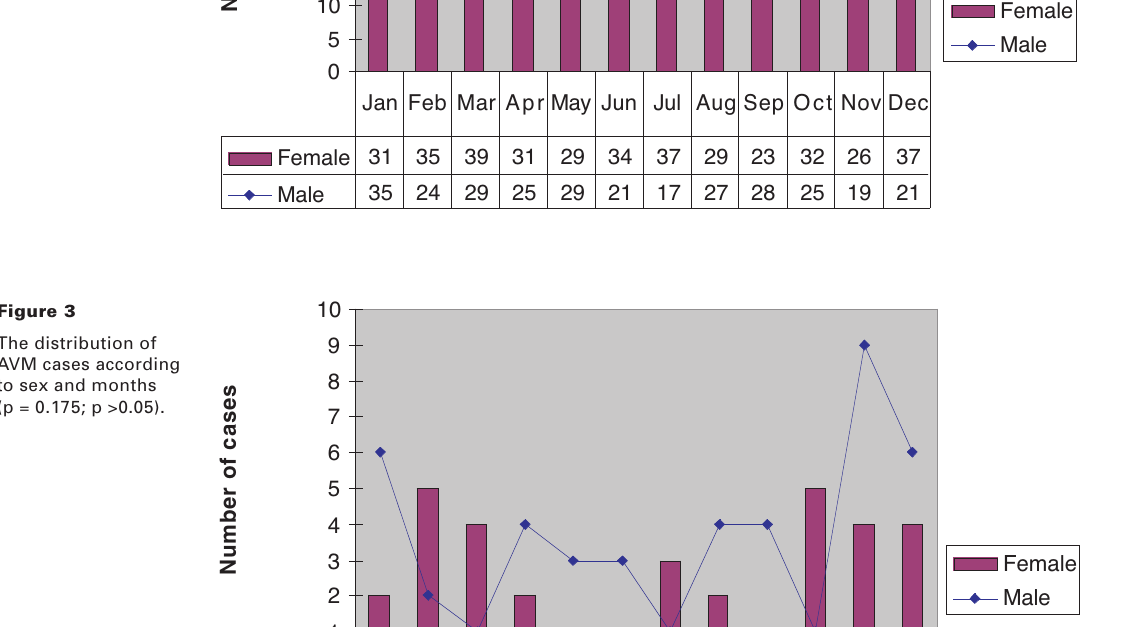
Feb Mar Apr May Jun Jul Aug Sep Oct Nov Dec